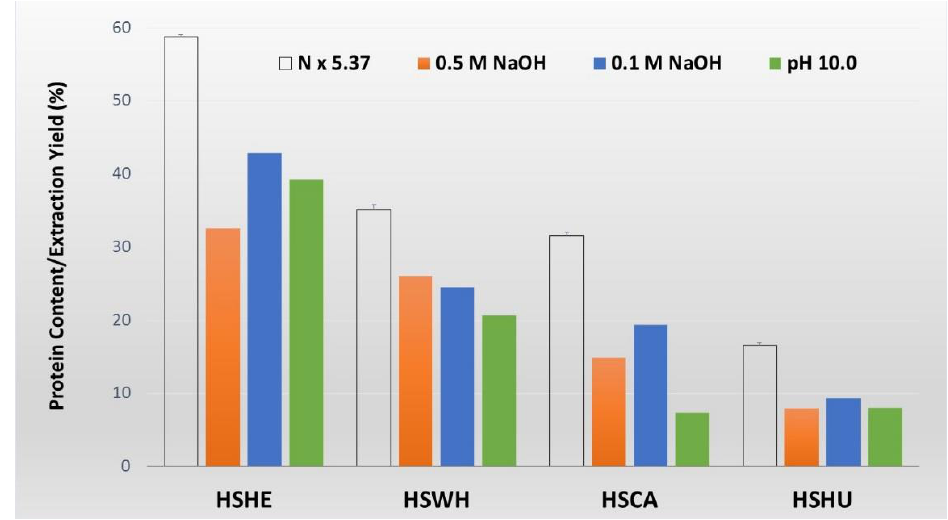
Figure 1 . Crude protein content and extraction yield of protein isolates from defatted hemp seeds and defatted by-products. HSHE — hemp hearts; HSWH — hemp whole seed; HSCA — hemp cake; HSHU — hemp seed hulls.